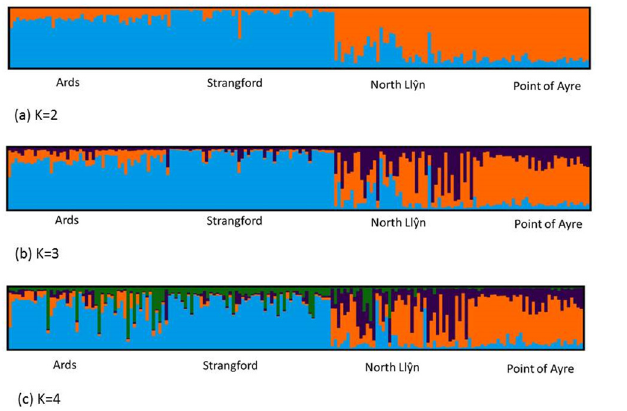
It has been demonstrated that the inclusion of markers with null alleles can lead to an over- ). Given that all but one of the markers and popula- estimation of the genetic differentiation (F st tions contained null alleles, it was therefore not possible to exclude the null allele markers from the calculations. To allow for this, Estimation of Null Allele (ENA) correction was performed was calculated before and after the correction proce- using FreeNA software and pairwise F st values before ENA correction ranged from 0.0023 (Strang- dure was applied [35]. Pairwise F st ford Lough/Ards Peninsula) to 0.10 (Strangford Lough/Point of Ayre); and after correction ranged from 0.01 (Strangford Lough/Ards Peninsula) to 0.12 (Strangford Lough/Point of Ayre) (Table 3). Following correction, values remained in the same order of magnitude, indicating estimates. that the presence of null alleles was not overly influencing F st The Fstat pairwise test for differentiation showed low but significant (p < 0.05) differentia- tion of Northern Ireland M . modiolus populations from Irish Sea counterparts (Ards Penin- sula-Point of Ayre = 0.07; Ards Peninsula-North Ll ŷ n = 0.05; Strangford Lough-Point of Ayre = 0.10; Strangford Lough-North Ll ŷ n = 0.07). The Strangford Lough/Ards Peninsula and North Ll ŷ n/Point of Ayre populations were not significantly differentiated. Results from data analysis in the software STRUCTURE and STRUCTURE Harvester indi- cated a mean Log Likelihood of K = 2 and the ‘ Evanno method ’ (the second order rate of change in the likelihood, DeltaK) K = 2 (Fig 4). The global Fst value (using ENA) was 0.06